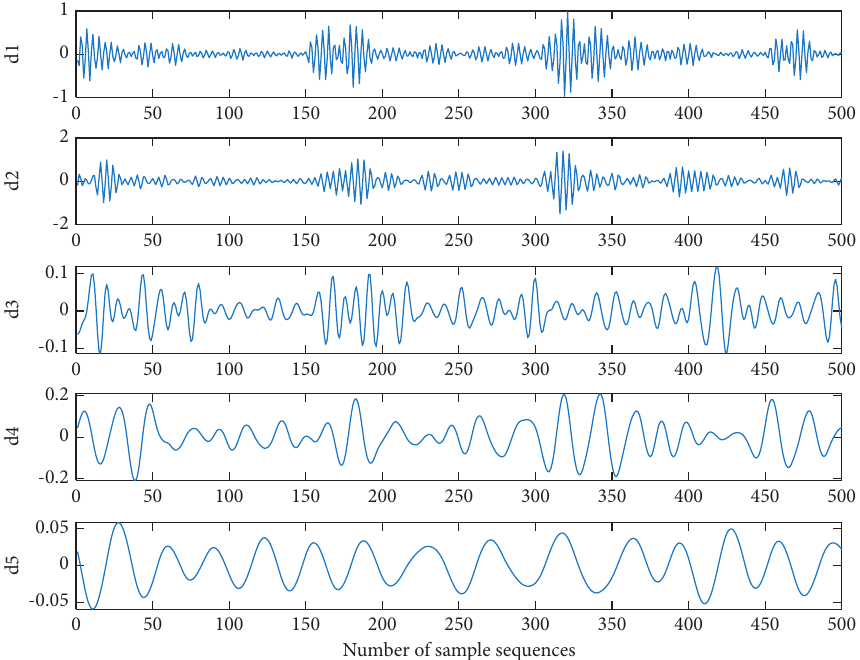
Figure 8: Wavelet decomposition chart of 0.3556mm inner race pitting.